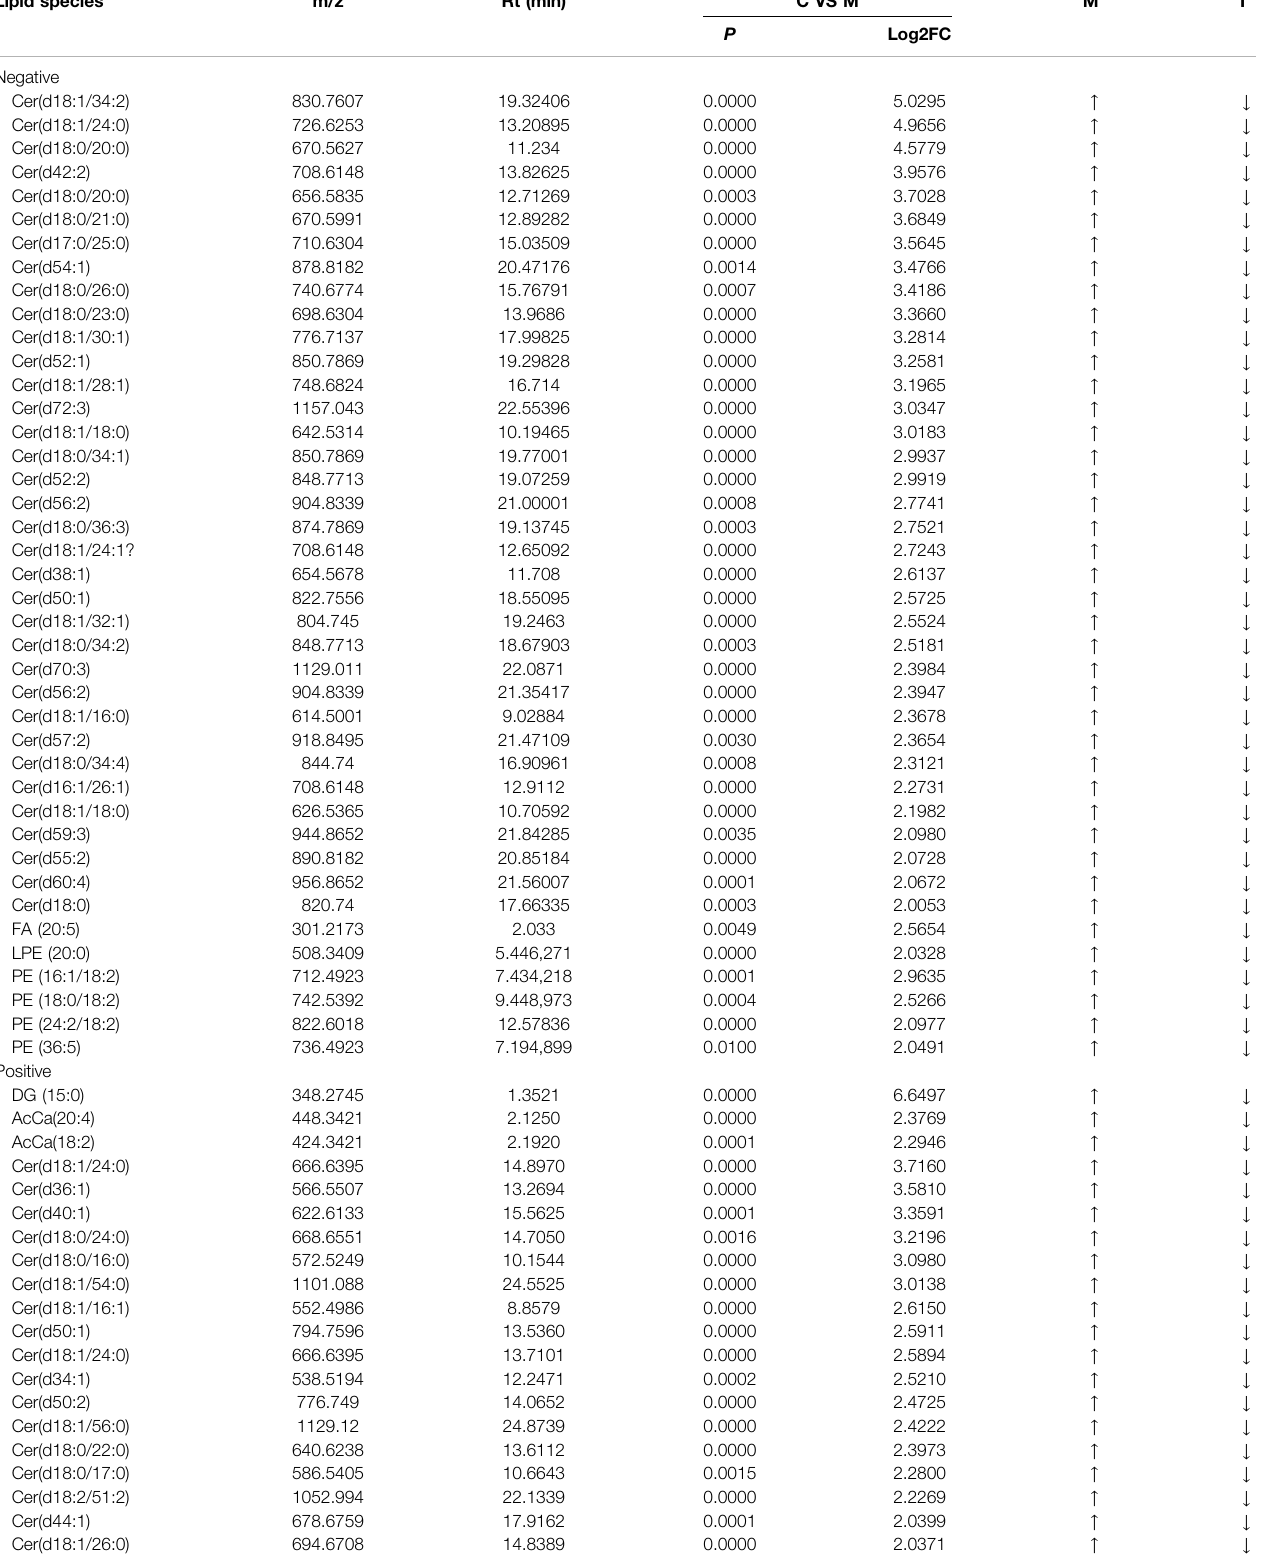
TABLE 2 | 96 identi fi ed potential biomarkers among the C, M and T. Lipid